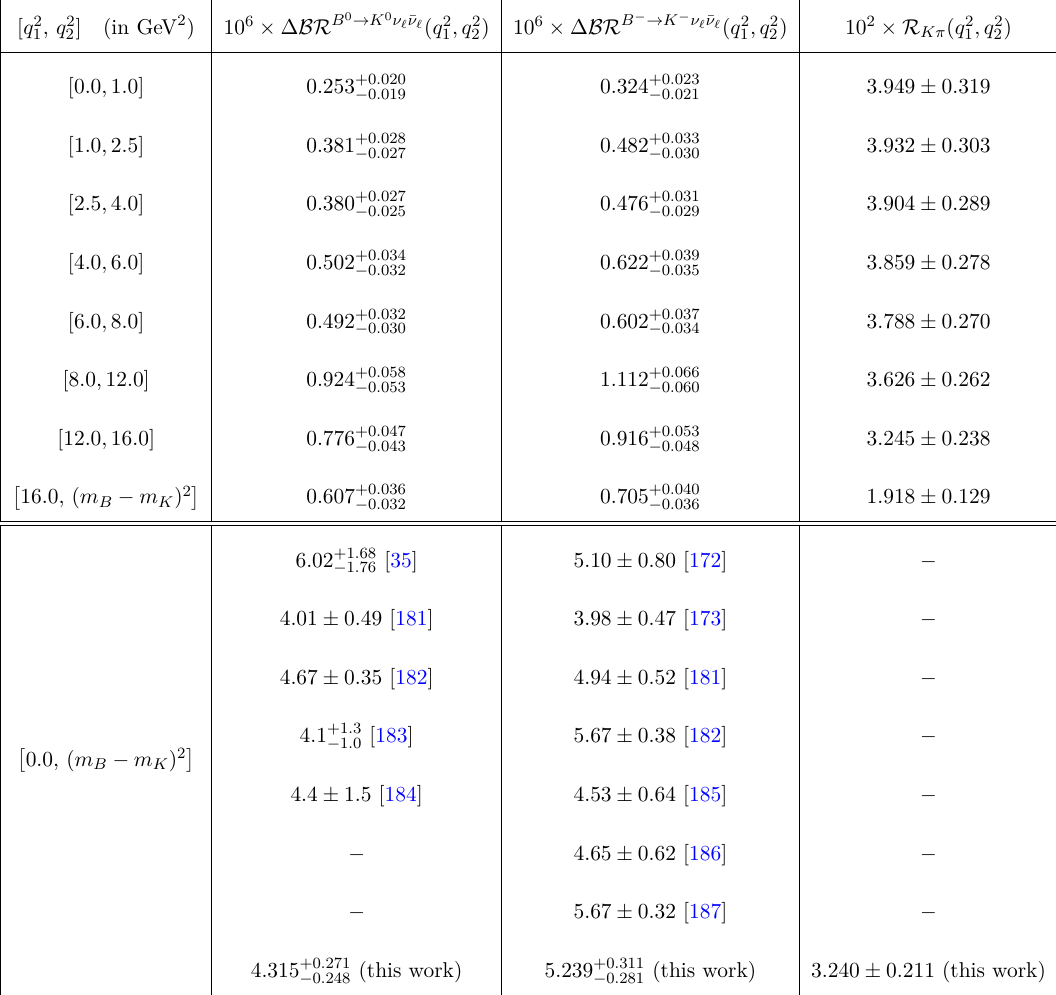
Theory predictions for the three partially integrated differential